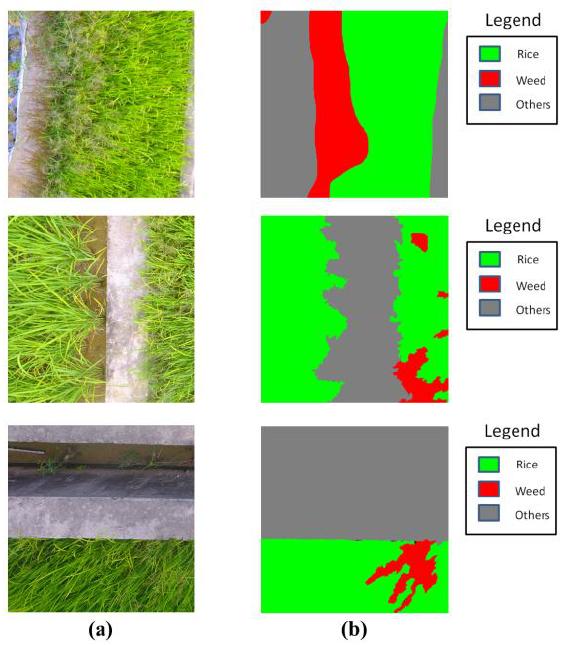
Figure 4. Three samples of our dataset: ( a ) aerial images; ( b ) corresponding GT labels.